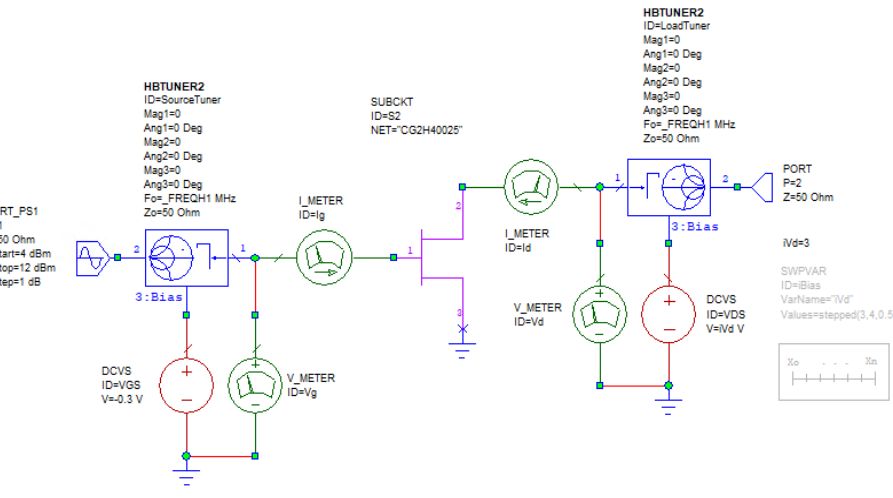
Fig. 2. Load-pull simulation